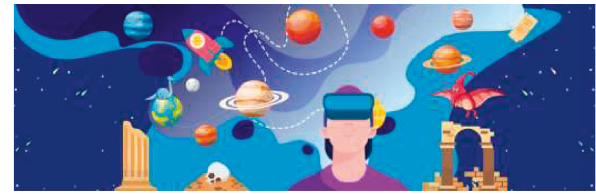
Figure 9: Virtual reality can help simulate any kind of virtual environment in the metaverse